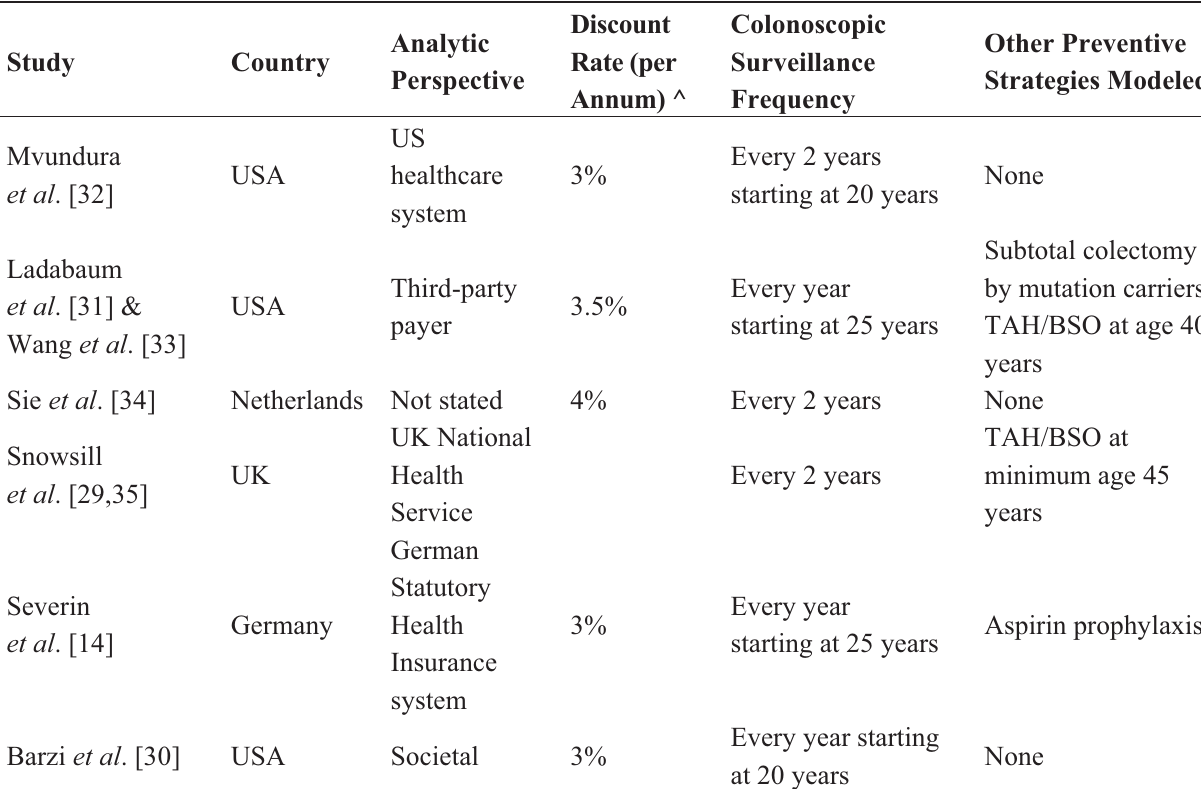
Table 1. Cost-effectiveness studies of testing strategies for Lynch Syndrome in patients with colorectal